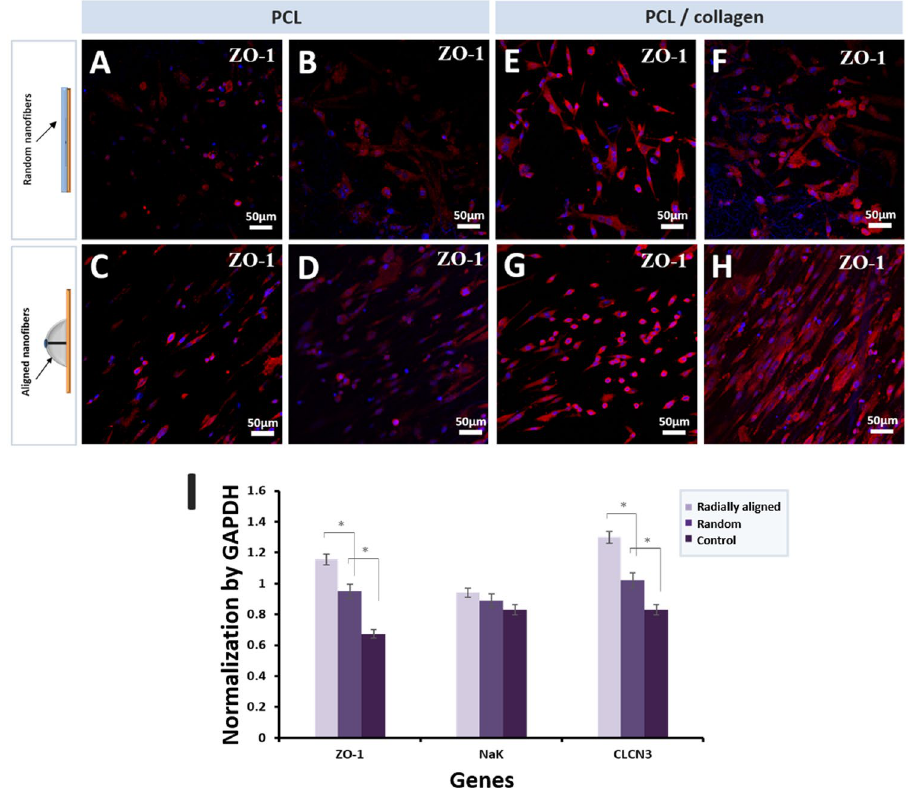
Figure 8. ( A , B ) Immunofluorescent staining of ZO-1 in the corneal cells after 3 and 7 days culture on the PCL random nanofibrous scaffolds. ( C , D ) Immunofluorescent staining of ZO-1 in the corneal cells after the 3 and 7 days culture on the PCL aligned nanofibrous scaffolds. ( E , F ) Immunofluorescent staining of ZO-1 in the corneal cells after the 3 and 7 days culture on the random PCL/collagen nanofibrous scaffolds. ( G , H ) Immunofluorescent staining of ZO-1 in the corneal cells after the 3 and 7 days culture on the aligned PCL/ collagen nanofibrous scaffolds (DAPI stained nuclei of the corneal cells were used for normalization). ( I ) Specific gene expression of rCCs by RT-PCR (normalized by